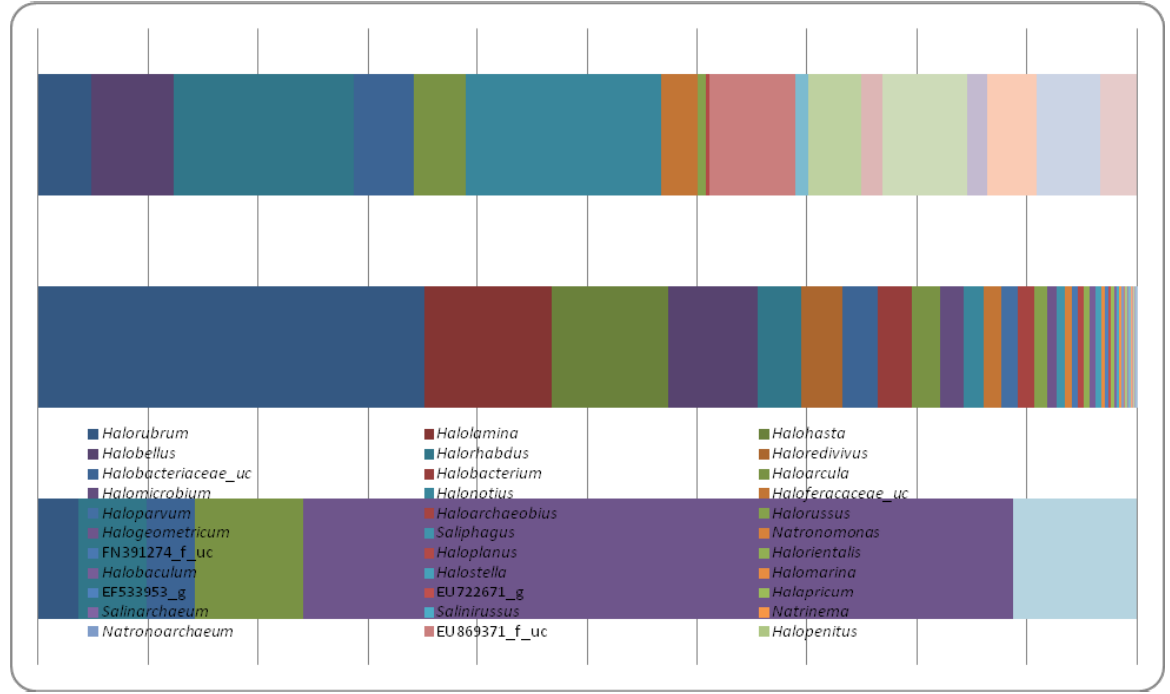
Figure 7. Bar plots showing the genus taxonomic abundance across the samples. Taxa with low abundance (<1%) was eliminated.